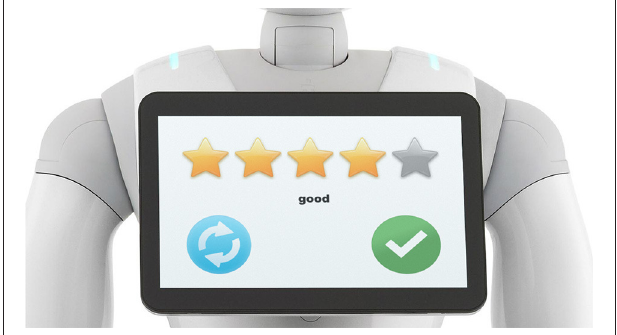
FIGURE 2 | Detection of ball and cup at the respective frame of interest in side and top view.